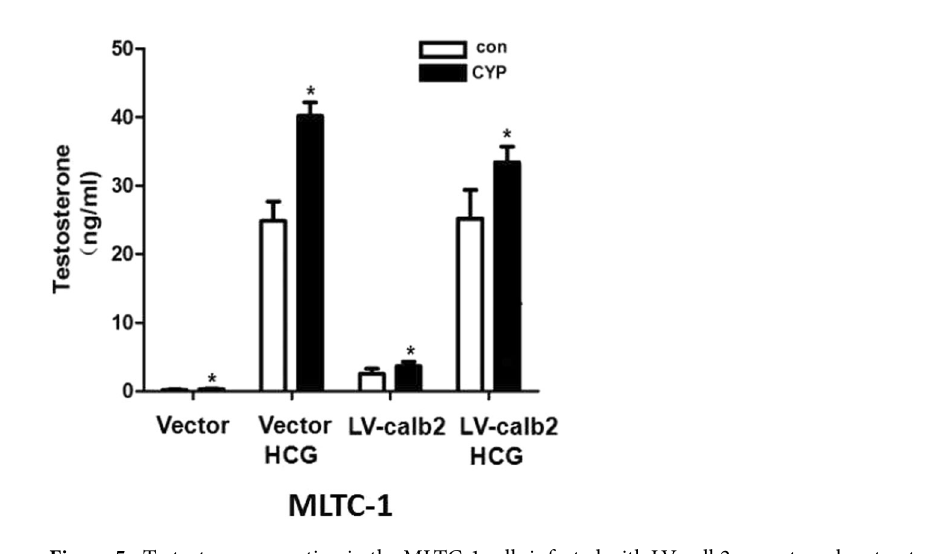
Figure 5. Testosterone secretion in the MLTC-1 cells infected with LV-calb2 or vector when treated by hCG and Ca2 + releasing agent CYP. The testosterone production was significantly increased by hCG treatment. the testosterone production in the LV-calb2 infected MLTC-1 cells after hCG treatment was not significantly higher than that in the vector infected cells. After the vector or LV-calb2 infected MLTC-1 cells were stimulated by CYP, the testosterone production was significantly increased regardless of the presence of hCG treatment, All experiments were independently repeated three times. * p <